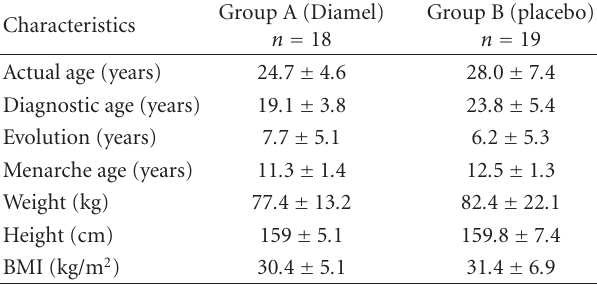
Algorithm on screening and follow up of patients with PCOS